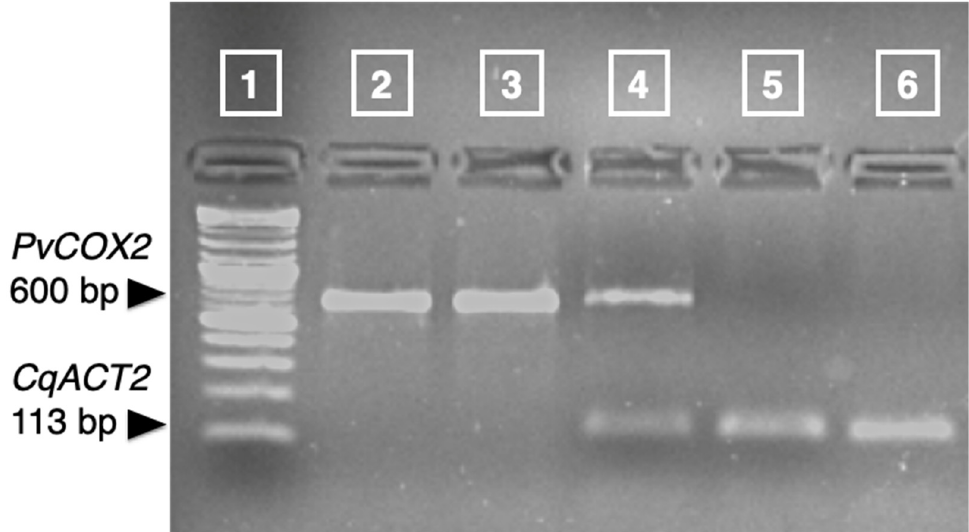
Figure 5. Detection of P. variabilis by RT-PCR of the cytochrome c oxidase subunit 2 gene. Lane 1 : 2-log DNA ladder (New England Biolabs); lane 2 : P. variabilis genomic DNA; lane 3 : P. variabilis cDNA; lane 4 : cDNA derived from a plant infected with P. variabilis , amplicons of PvCOX2 and CqACT2 of the same sample were pooled down; lane 5 : cDNA derived from a mock-treated plant; lane 6 : C. quinoa genomic DNA.